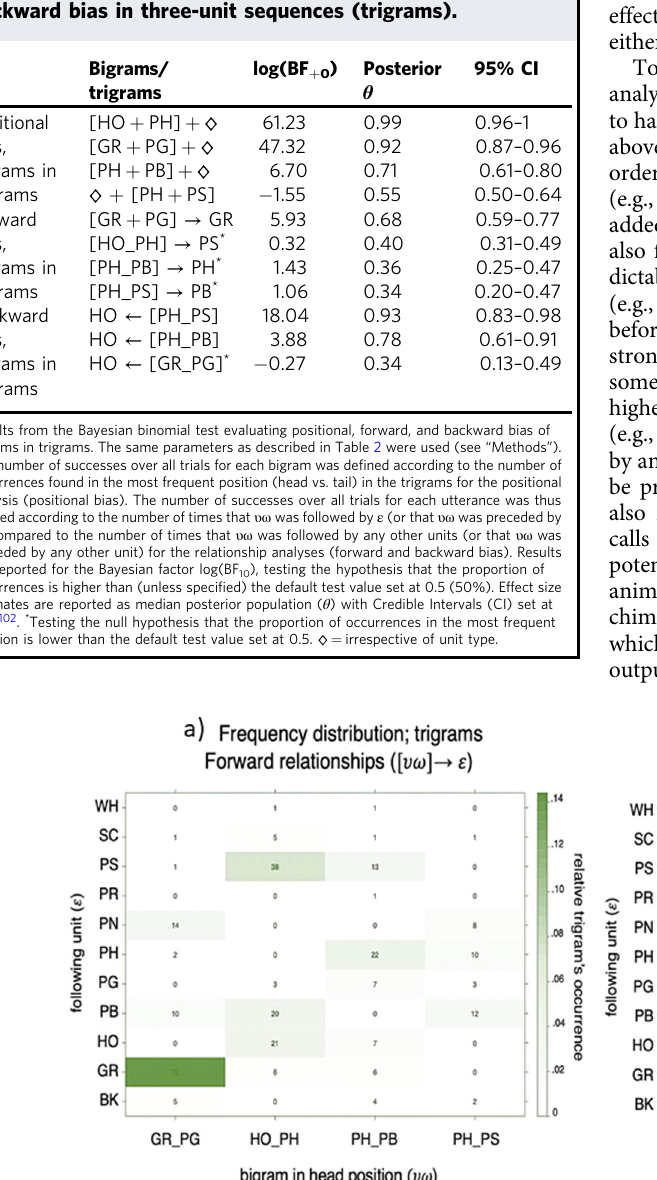
Table 4 Bayesian binomial test for positional, forward, and backward bias in three-unit sequences (trigrams).